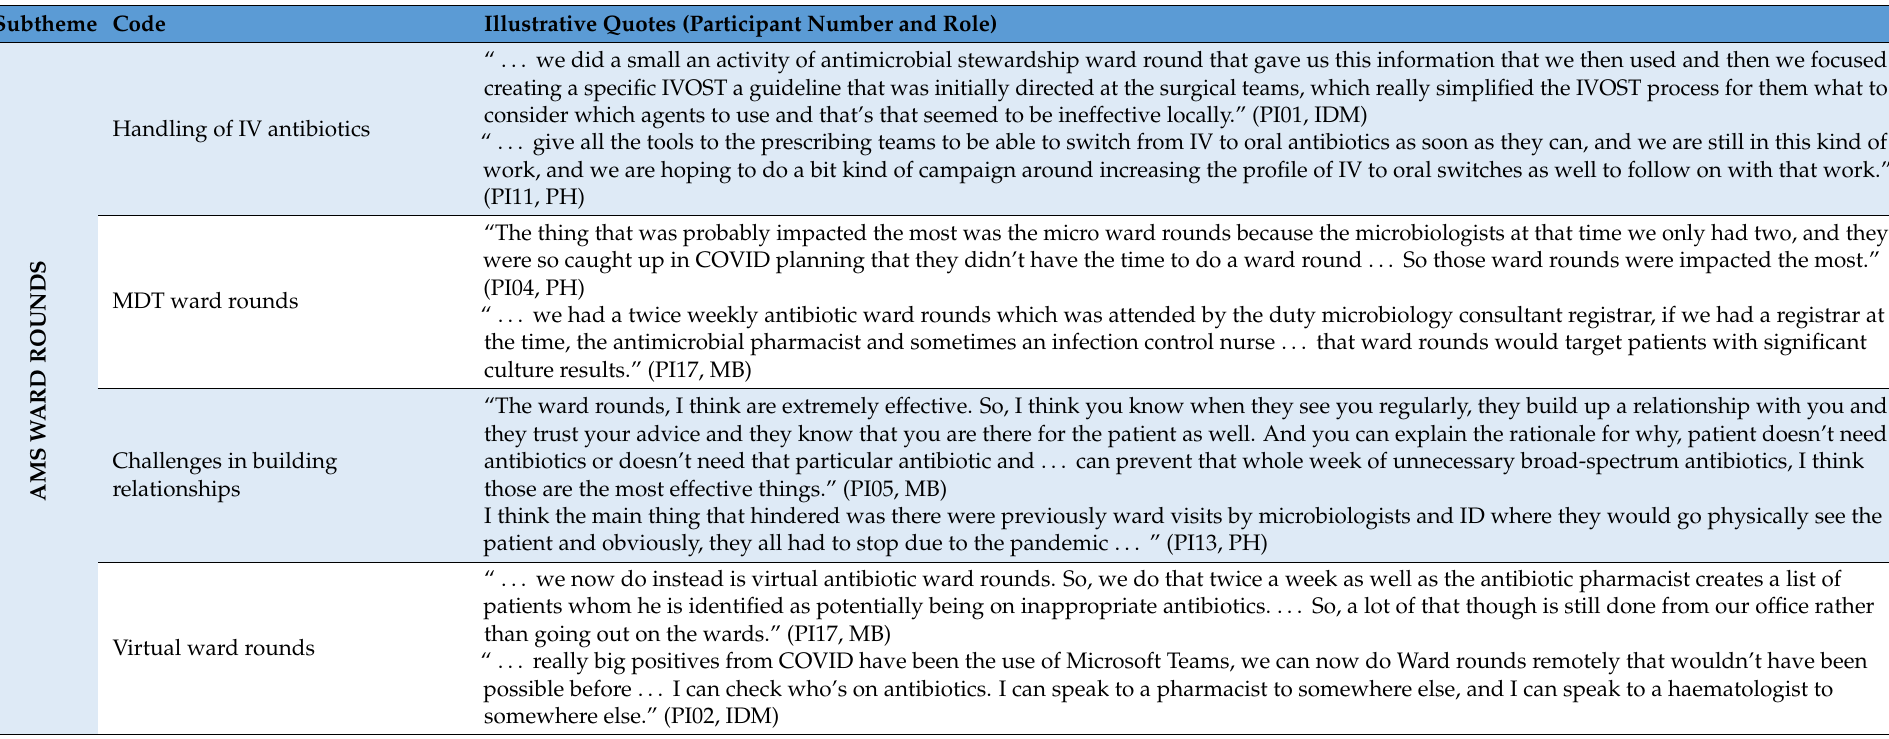
Table 2. THEME ONE: AMS activities or strategies before and during the